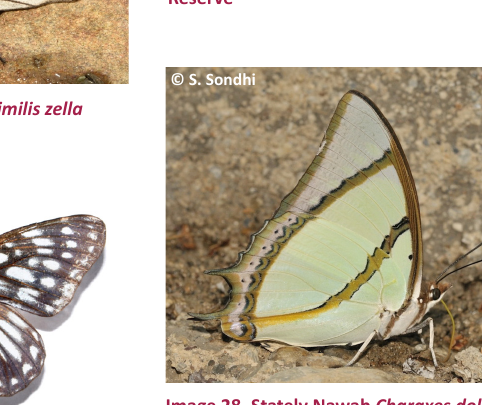
Image 28. Stately Nawab Charaxes dolon dolon— Magra RF, Tehri Garhwal